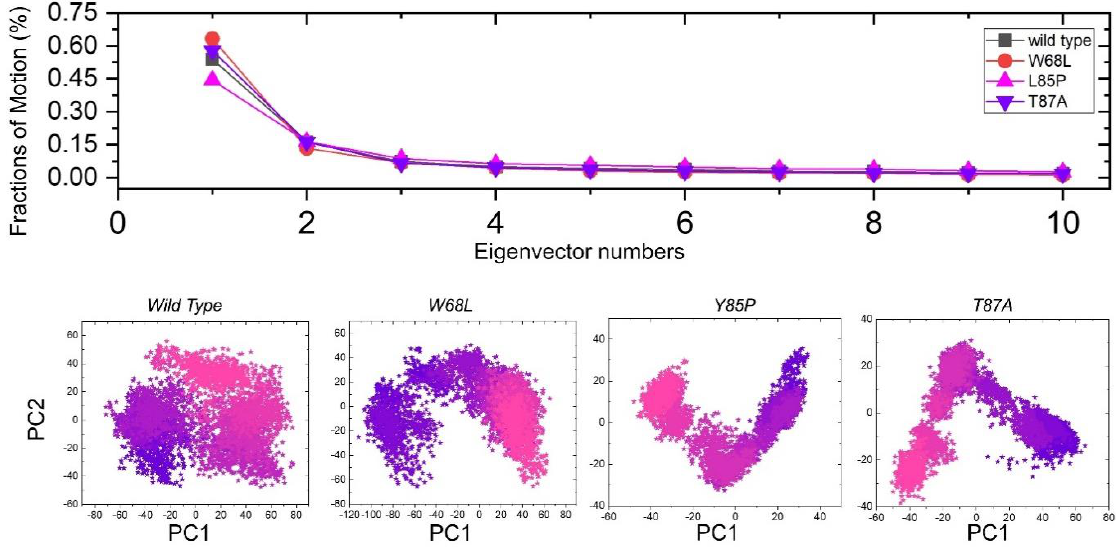
Figure 7. Principal component analysis (PCA) of all the complexes, i.e., wildtype, W68L, L85P, and T87A. The first PC1 and second PC2 from the PCA of the backbone carbon were used.